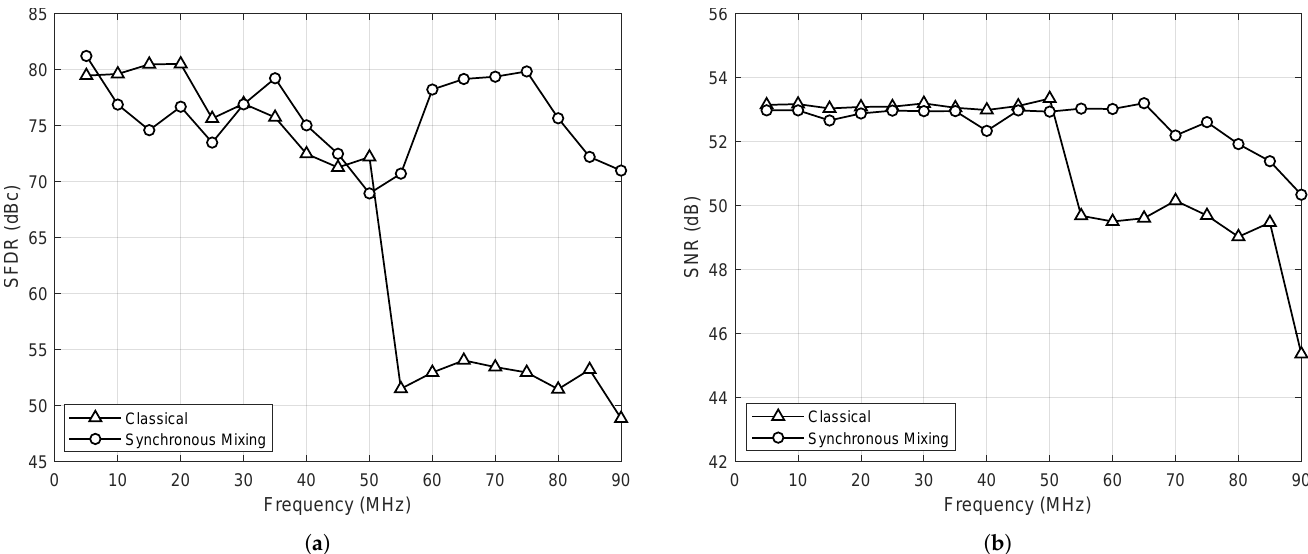
Figure 16. SFDR and SNR of the classical and synchronous mixing architectures: ( a ) SFDR; ( b )